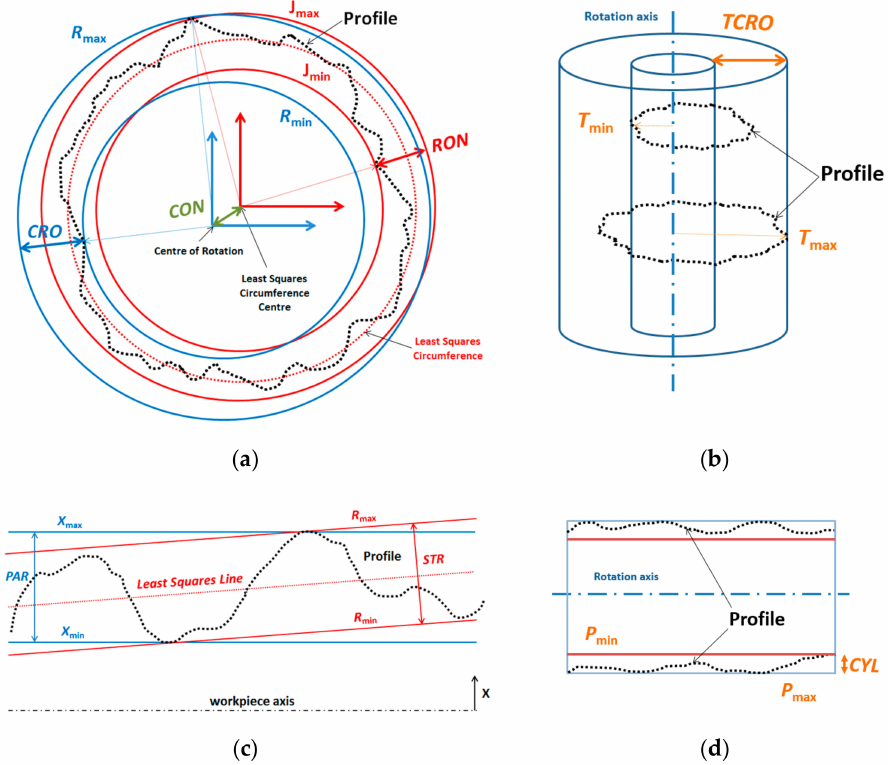
Figure 6. Macrogeometrical deviations: ( a ) RON, CON and CRO, ( b ) total circular run-out (TCRO), ( c ) STR and PAR and ( d ) cylindricity